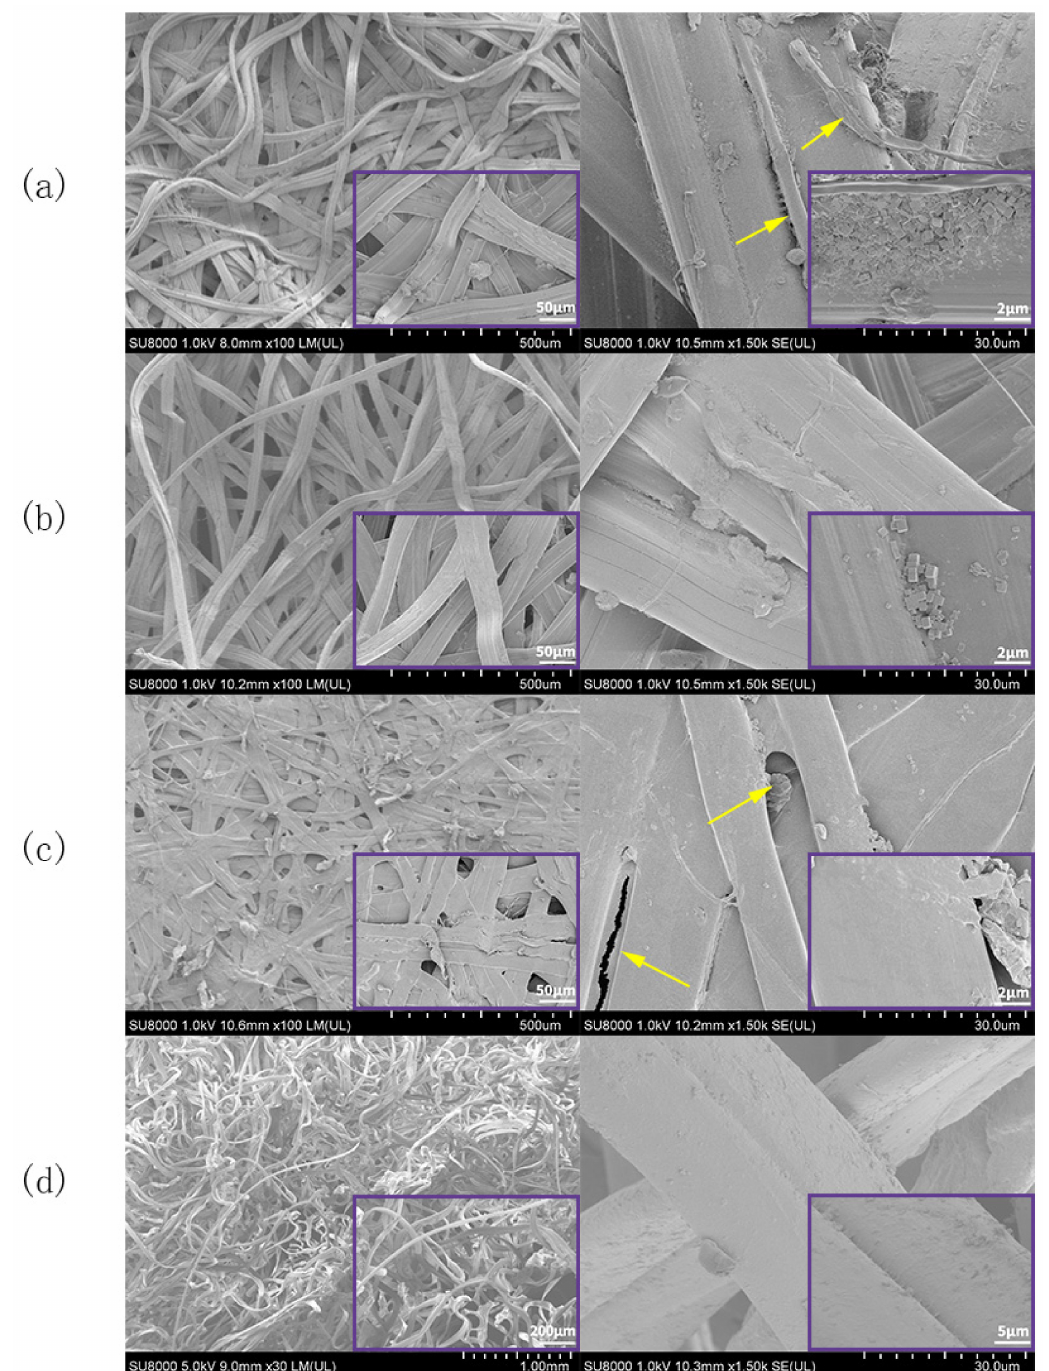
Figure 5. SEM images of the microstructures of E cocoon: ( a ) cocoon coat; ( b ) cocoon layer; ( c ) cocoon lining; and ( d ) outer layer of eclosion hole. The yellow arrow in Figure 5a shows microfabrils of about 1 µ m in diameter. The yellow arrow in Figure 5c shows that sericin can not completely coat all silk fiber, The purple square frame (bottom right) shows a partial enlarged